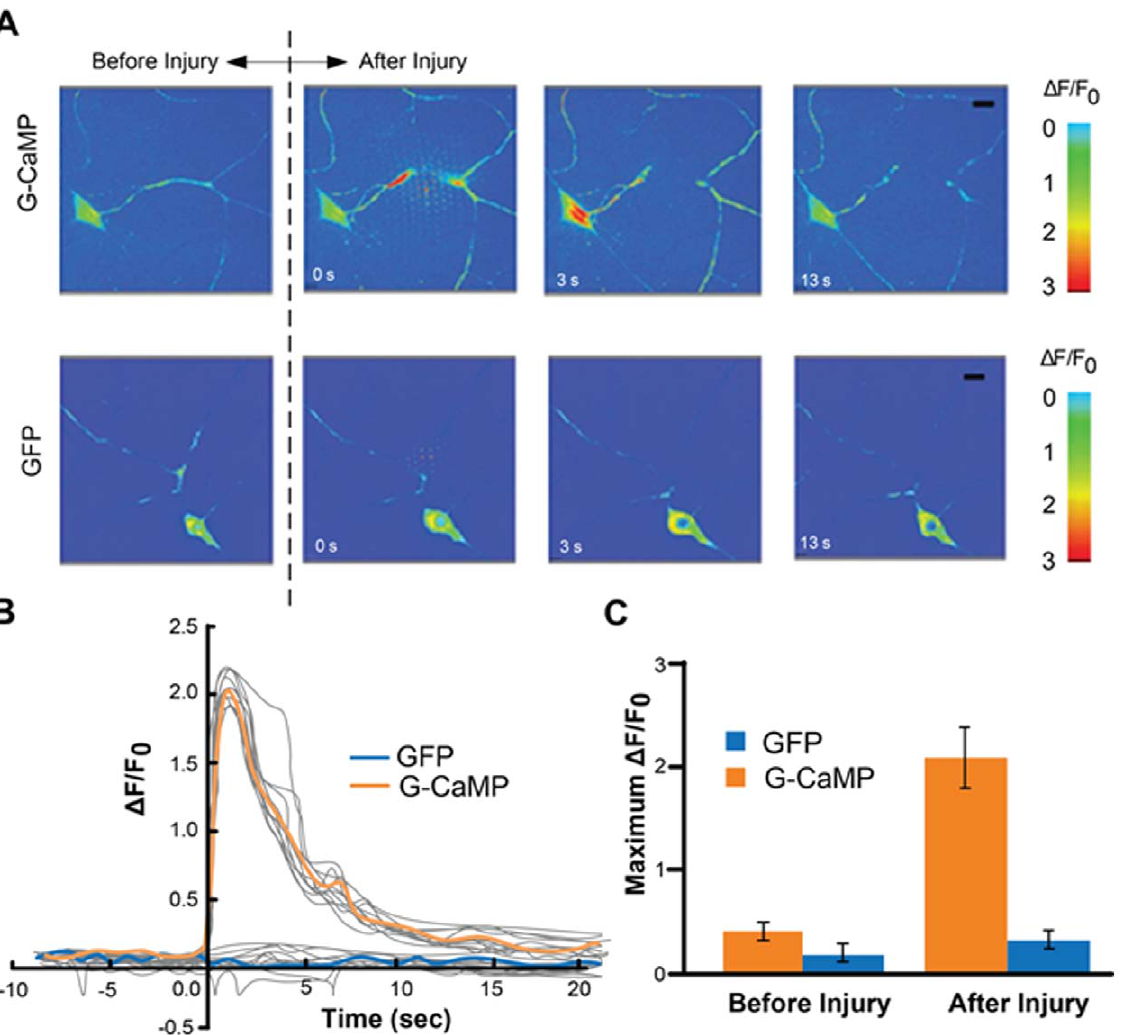
Figure 2. Calcium dynamics after laser microsurgery. (A) Time-lapse images from immobilized larvae depict intracellular calcium dynamics during laser microsurgery of a sensory neuron dendrite, using a pulsed UV laser (see also Movies S1 and S2). The ppk-Gal4 driver was used to express UAS-G-CaMP3.0 or UAS-mCD8-GFP. (B) Average normalized fluorescent intensity ( D F/F 0 ) was calculated in the cell bodies for G-CaMP3.0 and mCD8- GFP (sample size, n=12) before and after injury (injury is performed at 0 sec). A peak value in the intensity of G-CaMP is observed 2 seconds after injury. Calcium transients from individual larvae are depicted in light grey color. (C) Quantification of the maximum fluorescent intensity change (maximum D F/F 0 ). The fluorescent intensity from mCD8-GFP expressing neurons did not change significantly (p-value , 0.01, n=12).